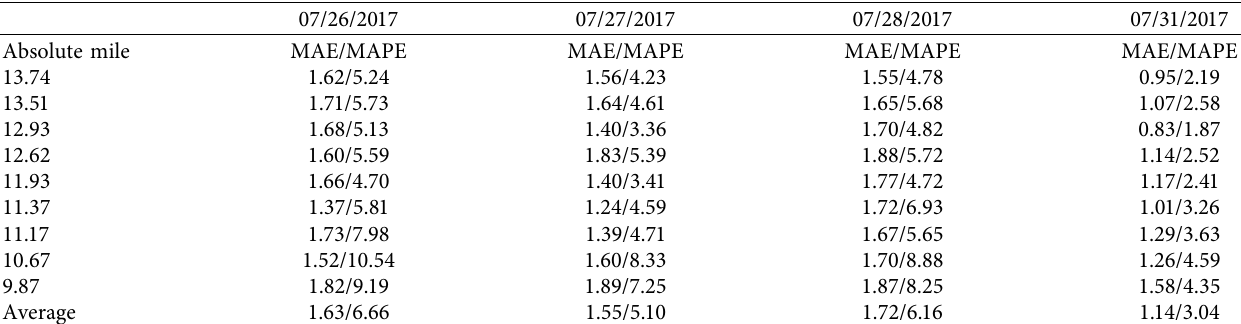
Figure 12: Comparison of speed estimation between model-driven and data-driven in the peak period. (a) Comparison estimation on 07/ 26/2017, (b) Comparison estimations on 07/27/2017, (c) Comparison estimation on 07/28/2017, and (d) Comparison estimations on 07/31/ 2017. Table 7: Comparison error between observations and estimations on diferent days on diferent absolute